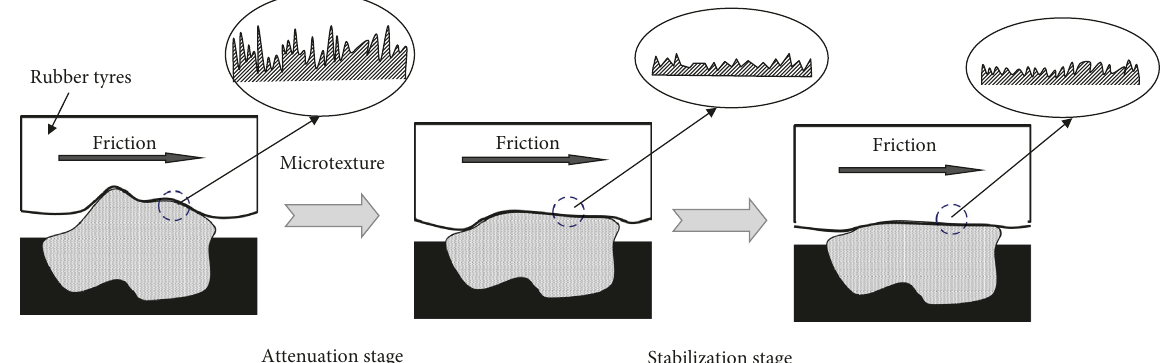
Figure 11: Schematic diagram of microtexture change during the long-term polishing process.